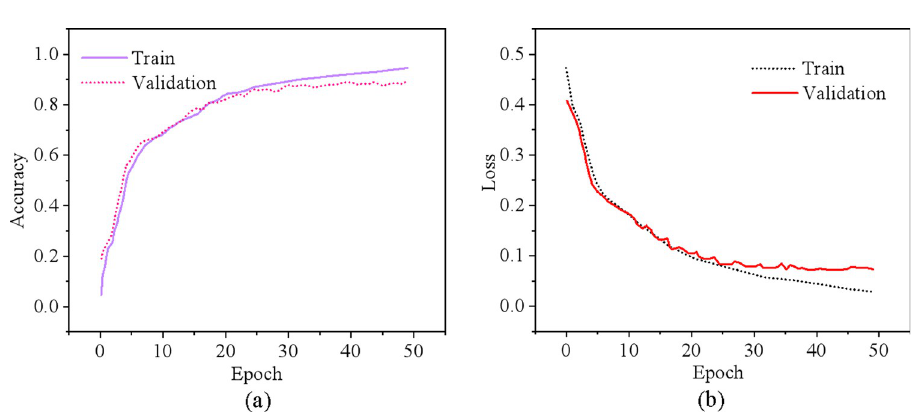
Fig 13. Results of the five-fold cross-validation of DEG screening and prediction (a: Accuracy; b: Loss).